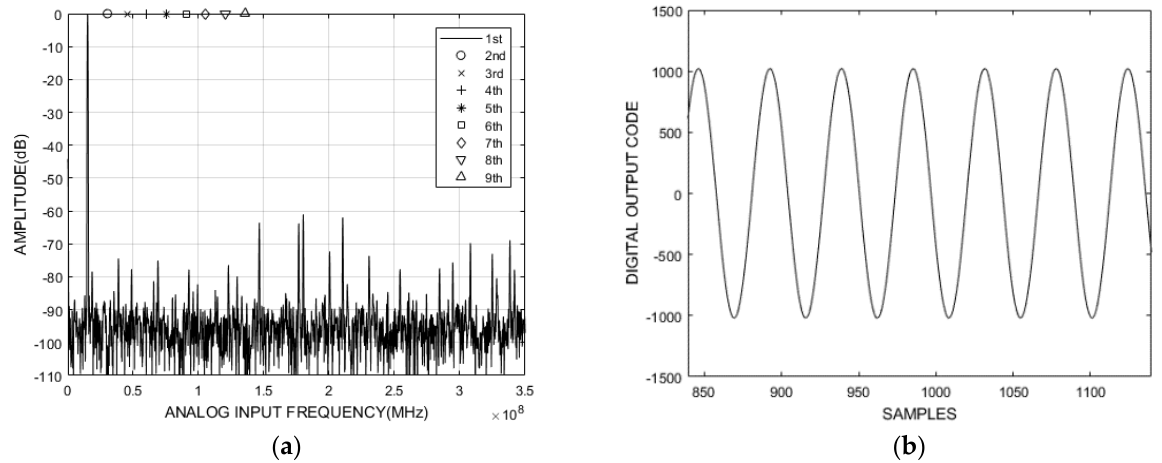
Figure 9. ( a ) The resampling spectrum when the interpolation factor of sinc is 8 and the filter parameter is 6; ( b ) Resampled time domain waveform with 8 × interpolation and a filter factor of 6.